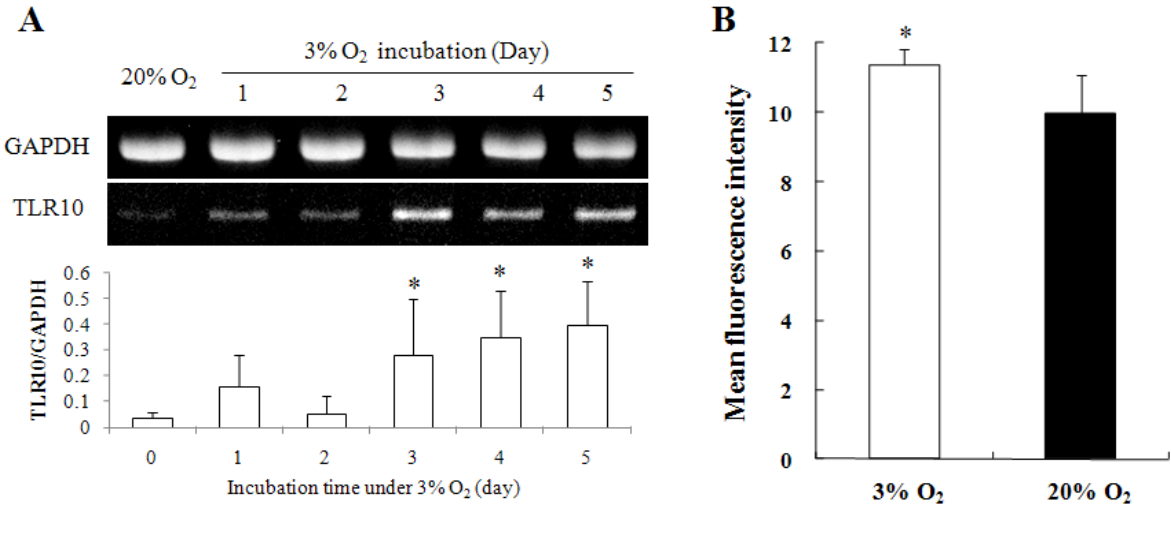
Figure 1. Hypoxia upregulated TLR10 expression in THP-1 cells. ( A ) A